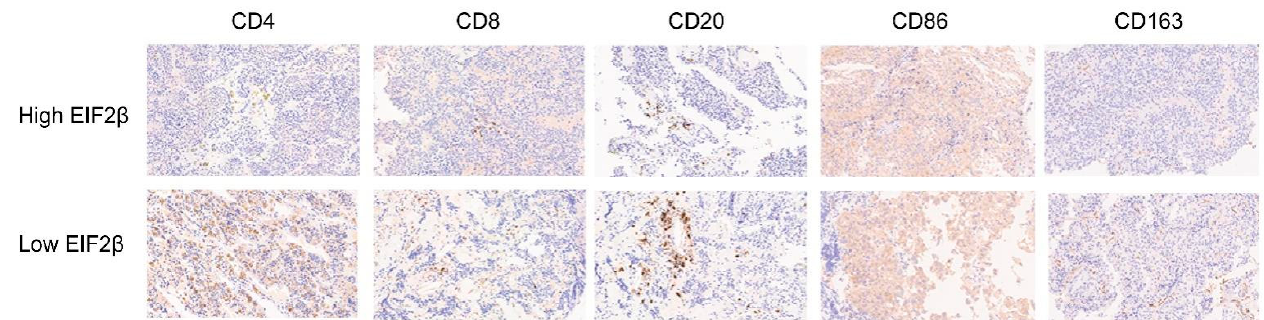
Figure 5. Immunohistochemistry images of CD4, CD8, CD20, CD86, and CD163 staining in the high- and low-EIF2 β patient groups (×: 40 fold). and low-EIF2 β patient groups ( × : 40